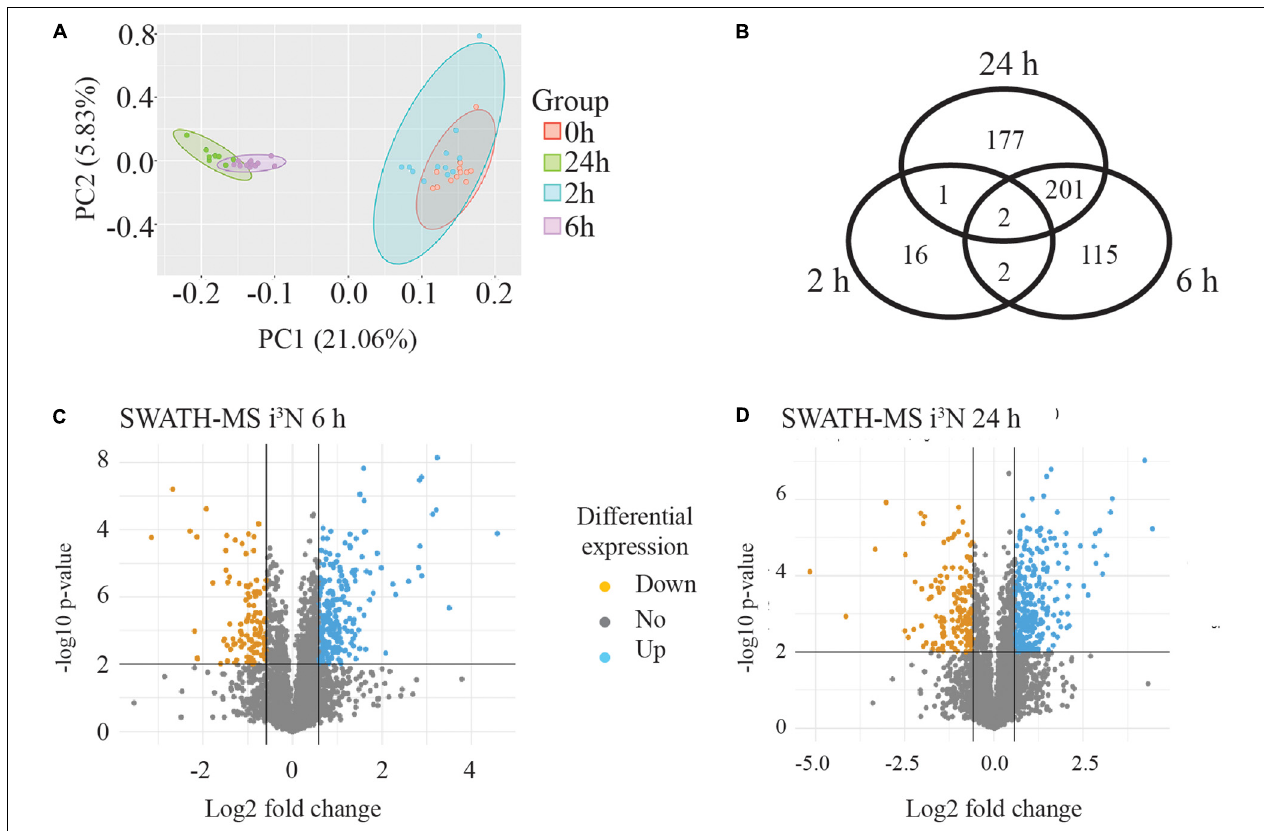
FIGURE 5 | SWATH-MS data analysis from human neurons treated with sAPP α . (A) PCA analysis illustrates four biological replicates and three technical replicates of the samples for each time point. The data from each time point is within an elipse. It showed that the data from 6 and 24 h data segregated from the 0 and 2 h data. (B) Venn diagram of significantly ( p ≤ 0.01) differentially regulated proteins revealed the number of proteins exclusive and in common to each time point compared to the zero time point. Inverse volcano plots the − log10 p -value ( y -axis) against Log2 fold change ( x -axis) at 6 h (C) and 24 h (D) to highlight any down regulated (orange point) and up regulated (blue point) proteins which meet criteria for selection of a minimum 1.5-fold change (log2 fold change ≤ − 0.58 or ≥ 0.58) with p -value ≤